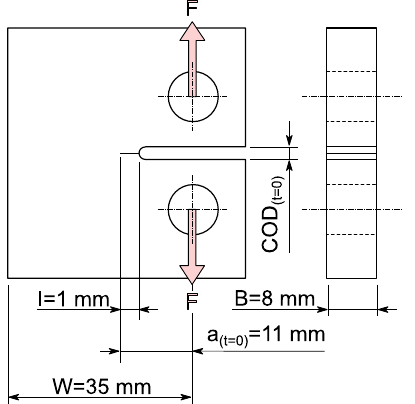
Figure 2. Compact Tension specimen with main dimensions and experimental parameters with I : notch depth by razor blade, W : specimen length, B : specimen thickness, a t = 0 : initial crack length, as well as COD ( t =0) : initial crack opening displacement and 𝐹 : applied force.